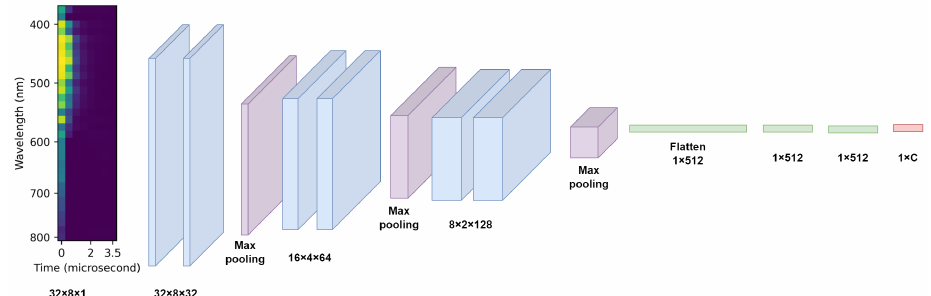
Figure 3. The scattering image feature extractor architecture, with C being the number of classes in each dataset.